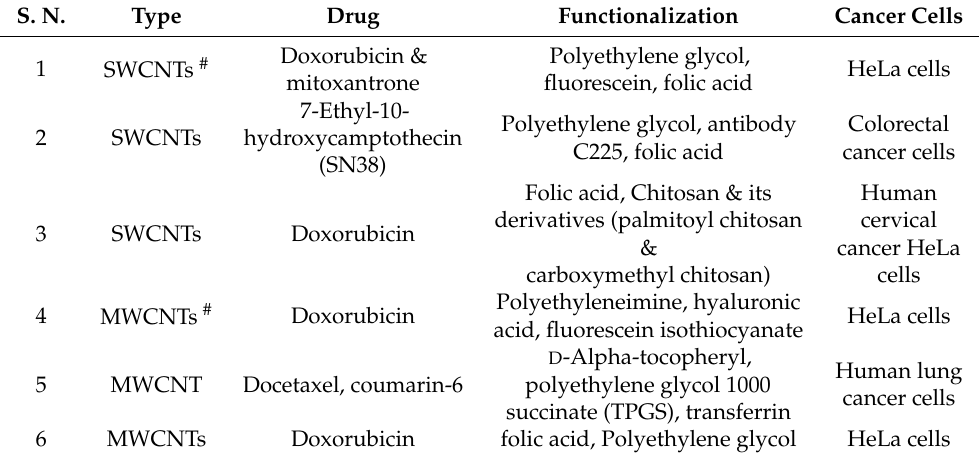
Table 4. CNTs for cancer therapy. Reproduced with permission from reference